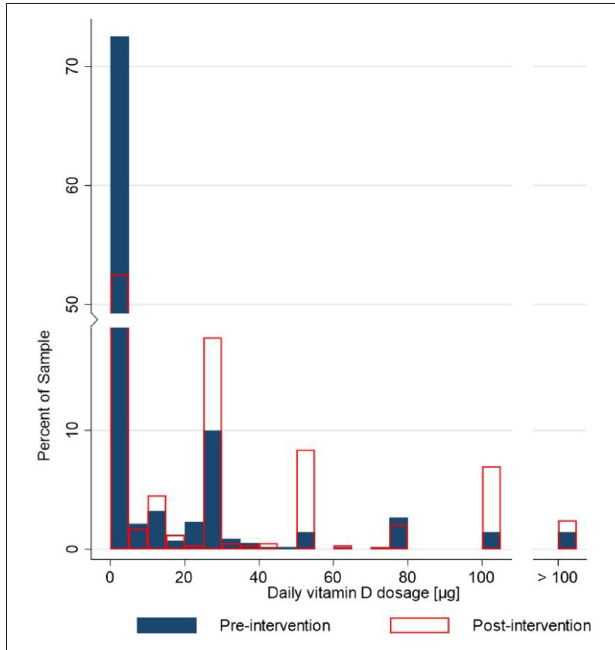
FIGURE 3 | Histogram of pre-intervention ( N = 573; April 2020: blue) and post-intervention ( N = 548; December 2020: red) daily vitamin D dosage ( µ g). The horizontal (x) scale uses daily vitamin D dosage, while the distribution in the population (% of the sample) is represented by the vertical bars. We excluded subjects reporting vitamin D supplementation, which did not report daily vitamin D dosage ( N = 41 in pre-intervention and N = 58 in post-intervention).